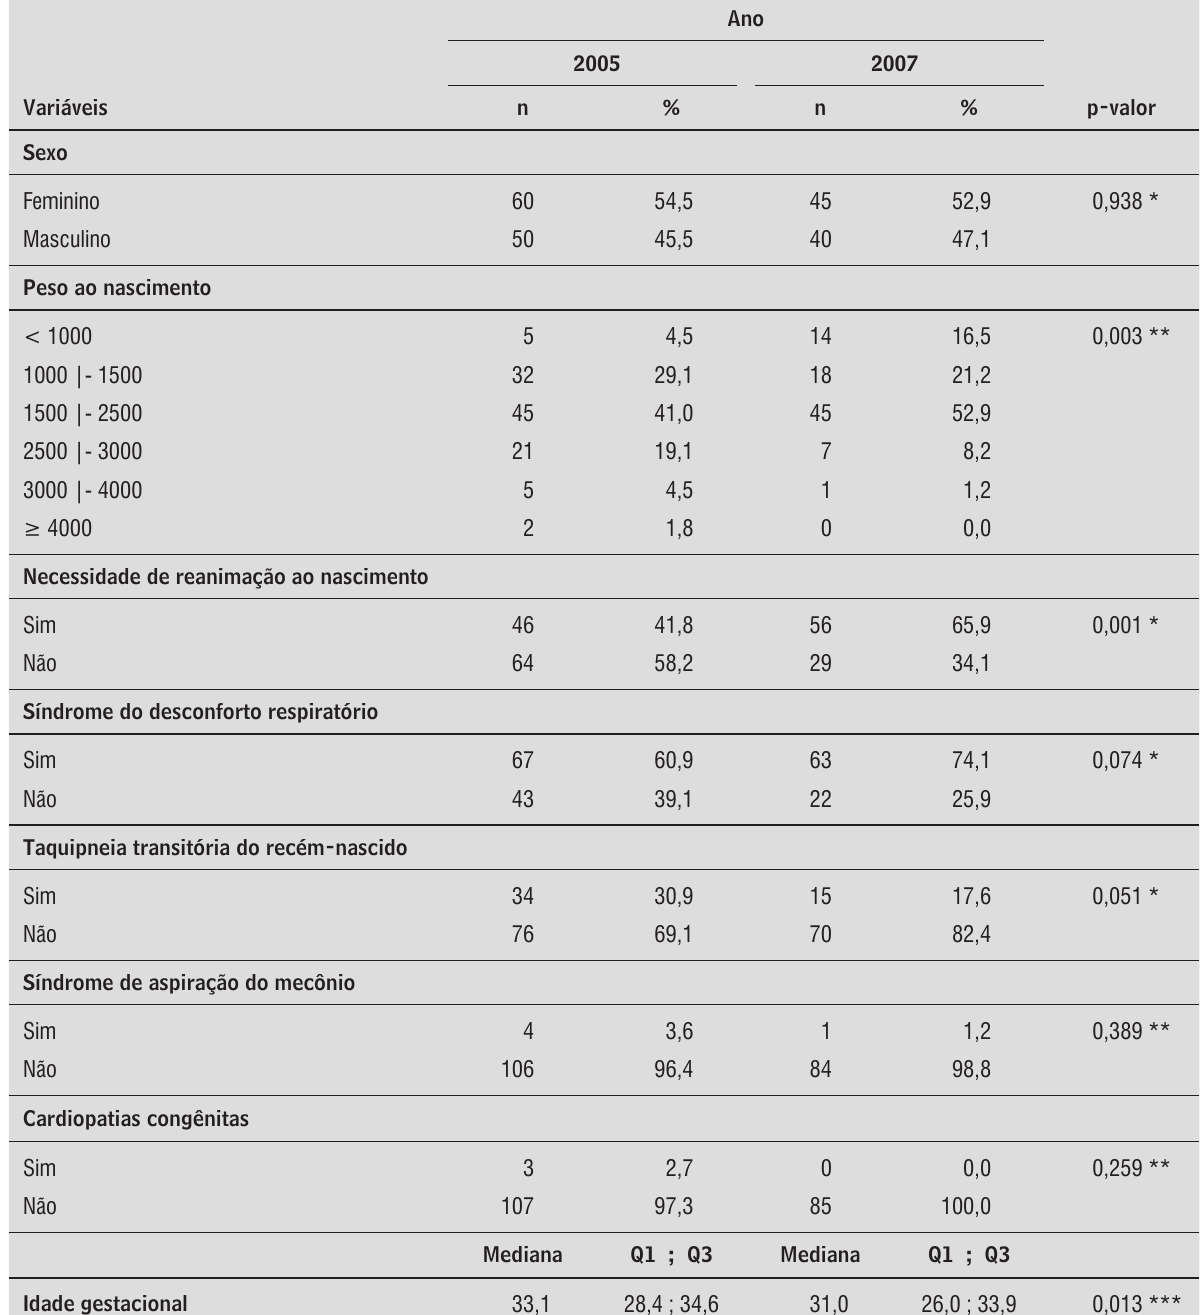
Tabela 2 - Características dos recém-nascidos internados na unidade de terapia intensiva neonatal do Hospital Agamenon Magalhães em Recife, PE, no período de janeiro a dezembro de 2005 e 2007